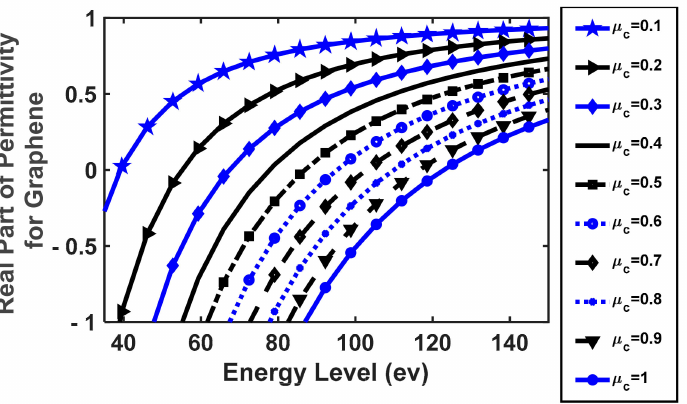
Figure 1. The real part of permittivity versus energy level with the chemical potentials of graphene (chemical potential is increased from 0.1 to 1 eV from left to right).